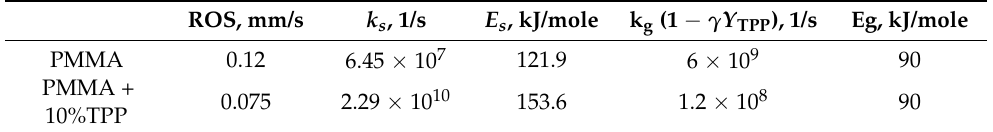
Figure 11. The temperature profiles in pure PMMA flame ( left ) and PMMA + 10%TPP flame ( right ) in the normal direction to the burning surface (legend shows the distance from the flame front). Solid lines—experiment; dashed lines—modeling.